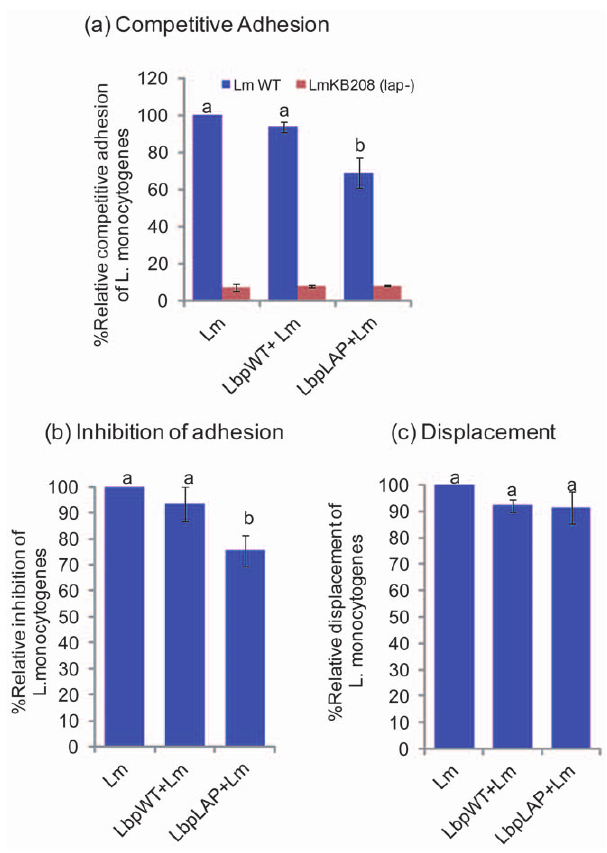
Figure 5. Competitive exclusion of Listeriamonocytogenes (Lm) adhesion to Caco-2 cells by recombinant Lactobacillusparacasei (Lbp LAP ), analyzed by three adhesion methods. (a) competitive adhesion: Caco-2 cells were exposed to wild type Lb. paracasei (Lbp WT ) or Lbp LAP with Lm simultaneously, (b) inhibition of adhesion: Caco-2 cells were pre-exposed to Lbp WT or Lbp LAP for 1 h before infection with Lm, and (c) displacement experiments: Caco-2 cells were infected with Lm for 1 h before Lbp WT or Lbp LAP addition. Adhesion of (Lm) alone to Caco-2 cells was presented as 100%. Lap -deficient LmKB208 was used as a negative control in the competitive adhesion assay. The data are average (SD) of three independent experiments performed in duplicate. Bars marked with letters (a, b) indicate significant difference at P ,